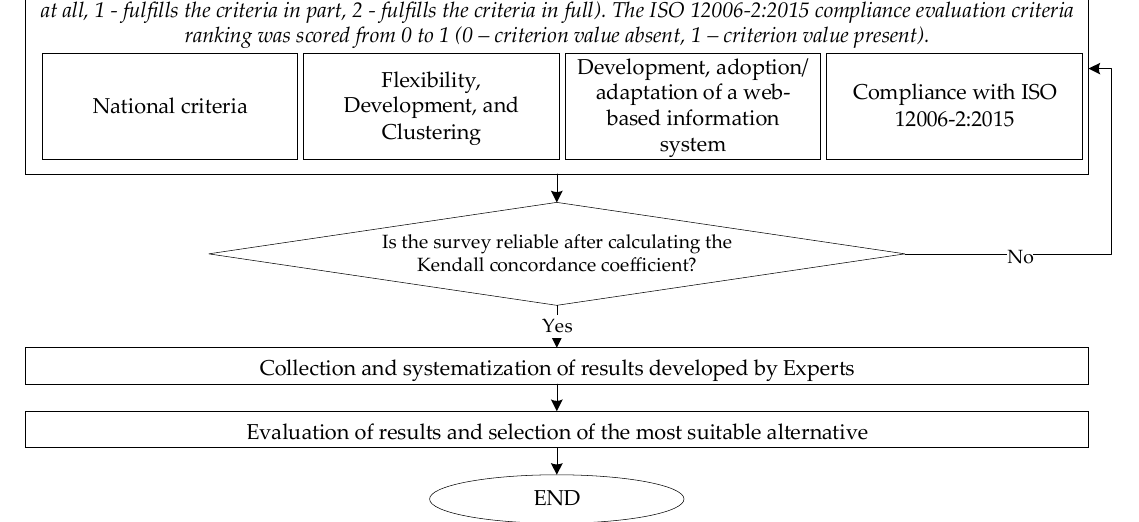
Figure 3. Schematic representation of expert evaluation of alternatives according to established evaluation criteria (drawn by authors).